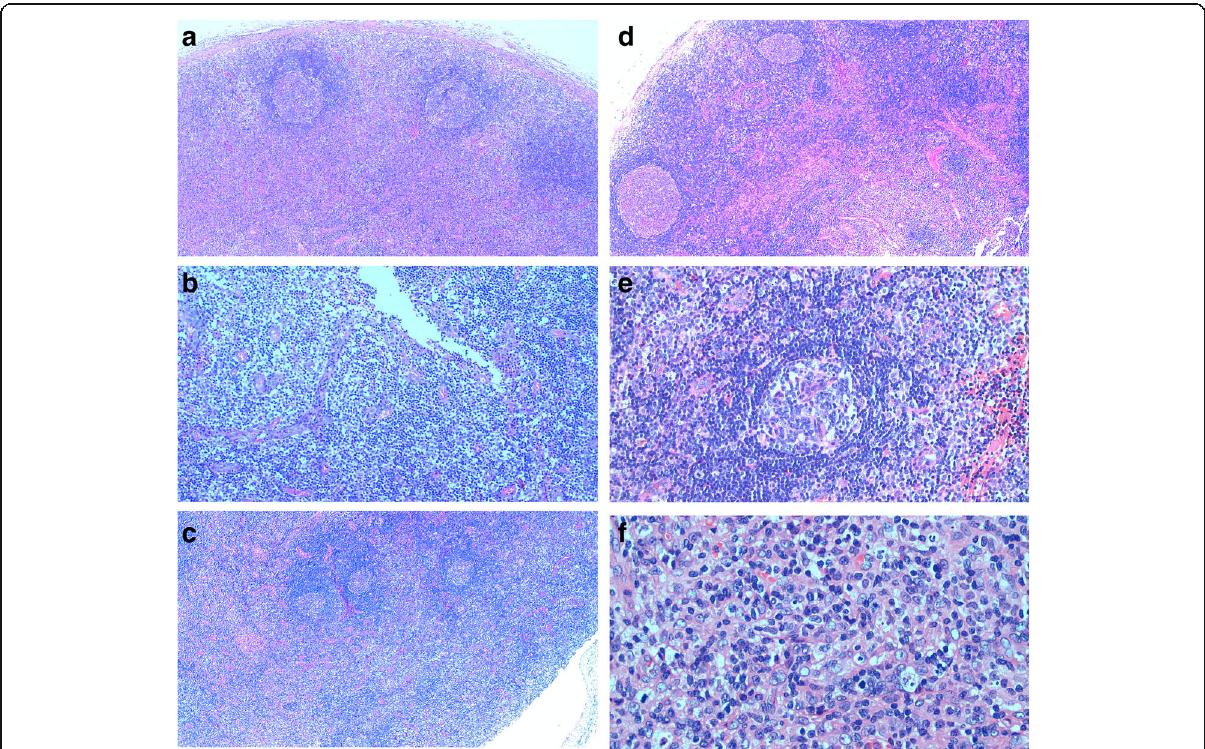
Fig. 2 Microscopic features. a . Lymph node structure is partially preserved, and residual lymph follicles can be seen (HE, × 40); b . The subcapsular and medullary sinuses are slightly expanded, and the sinus comprises a larger amount of histiocytes (HE, × 100); c . The cortical areas are atrophic and smaller (HE, × 40); d . A few lymphoid follicles of various sizes are observed (HE, × 40); e . Some of the follicular germinal centers are atrophic and smaller (HE, × 100);f. Lymph node paracortical areas are diffusely proliferative and enlarged,and consist mainly of histiocytes, immunoblasts, and medium-sized T lymphocytes (HE, ×